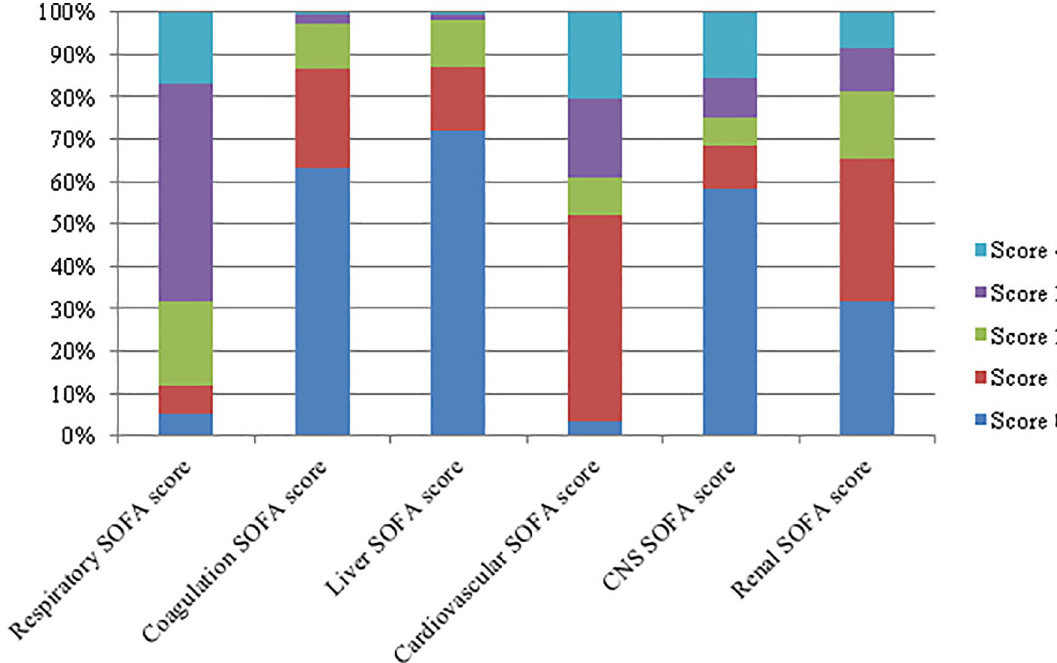
Fig 2. Distribution of individual SOFA organ sub-scores in final study population.